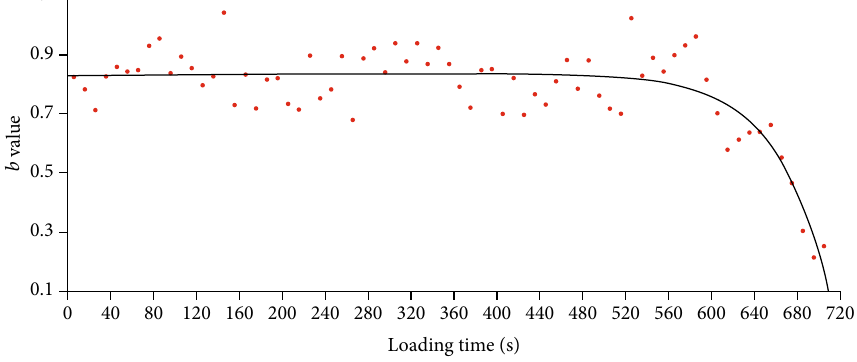
Figure 11: Change of b value of Gutenberg-Richter during loading